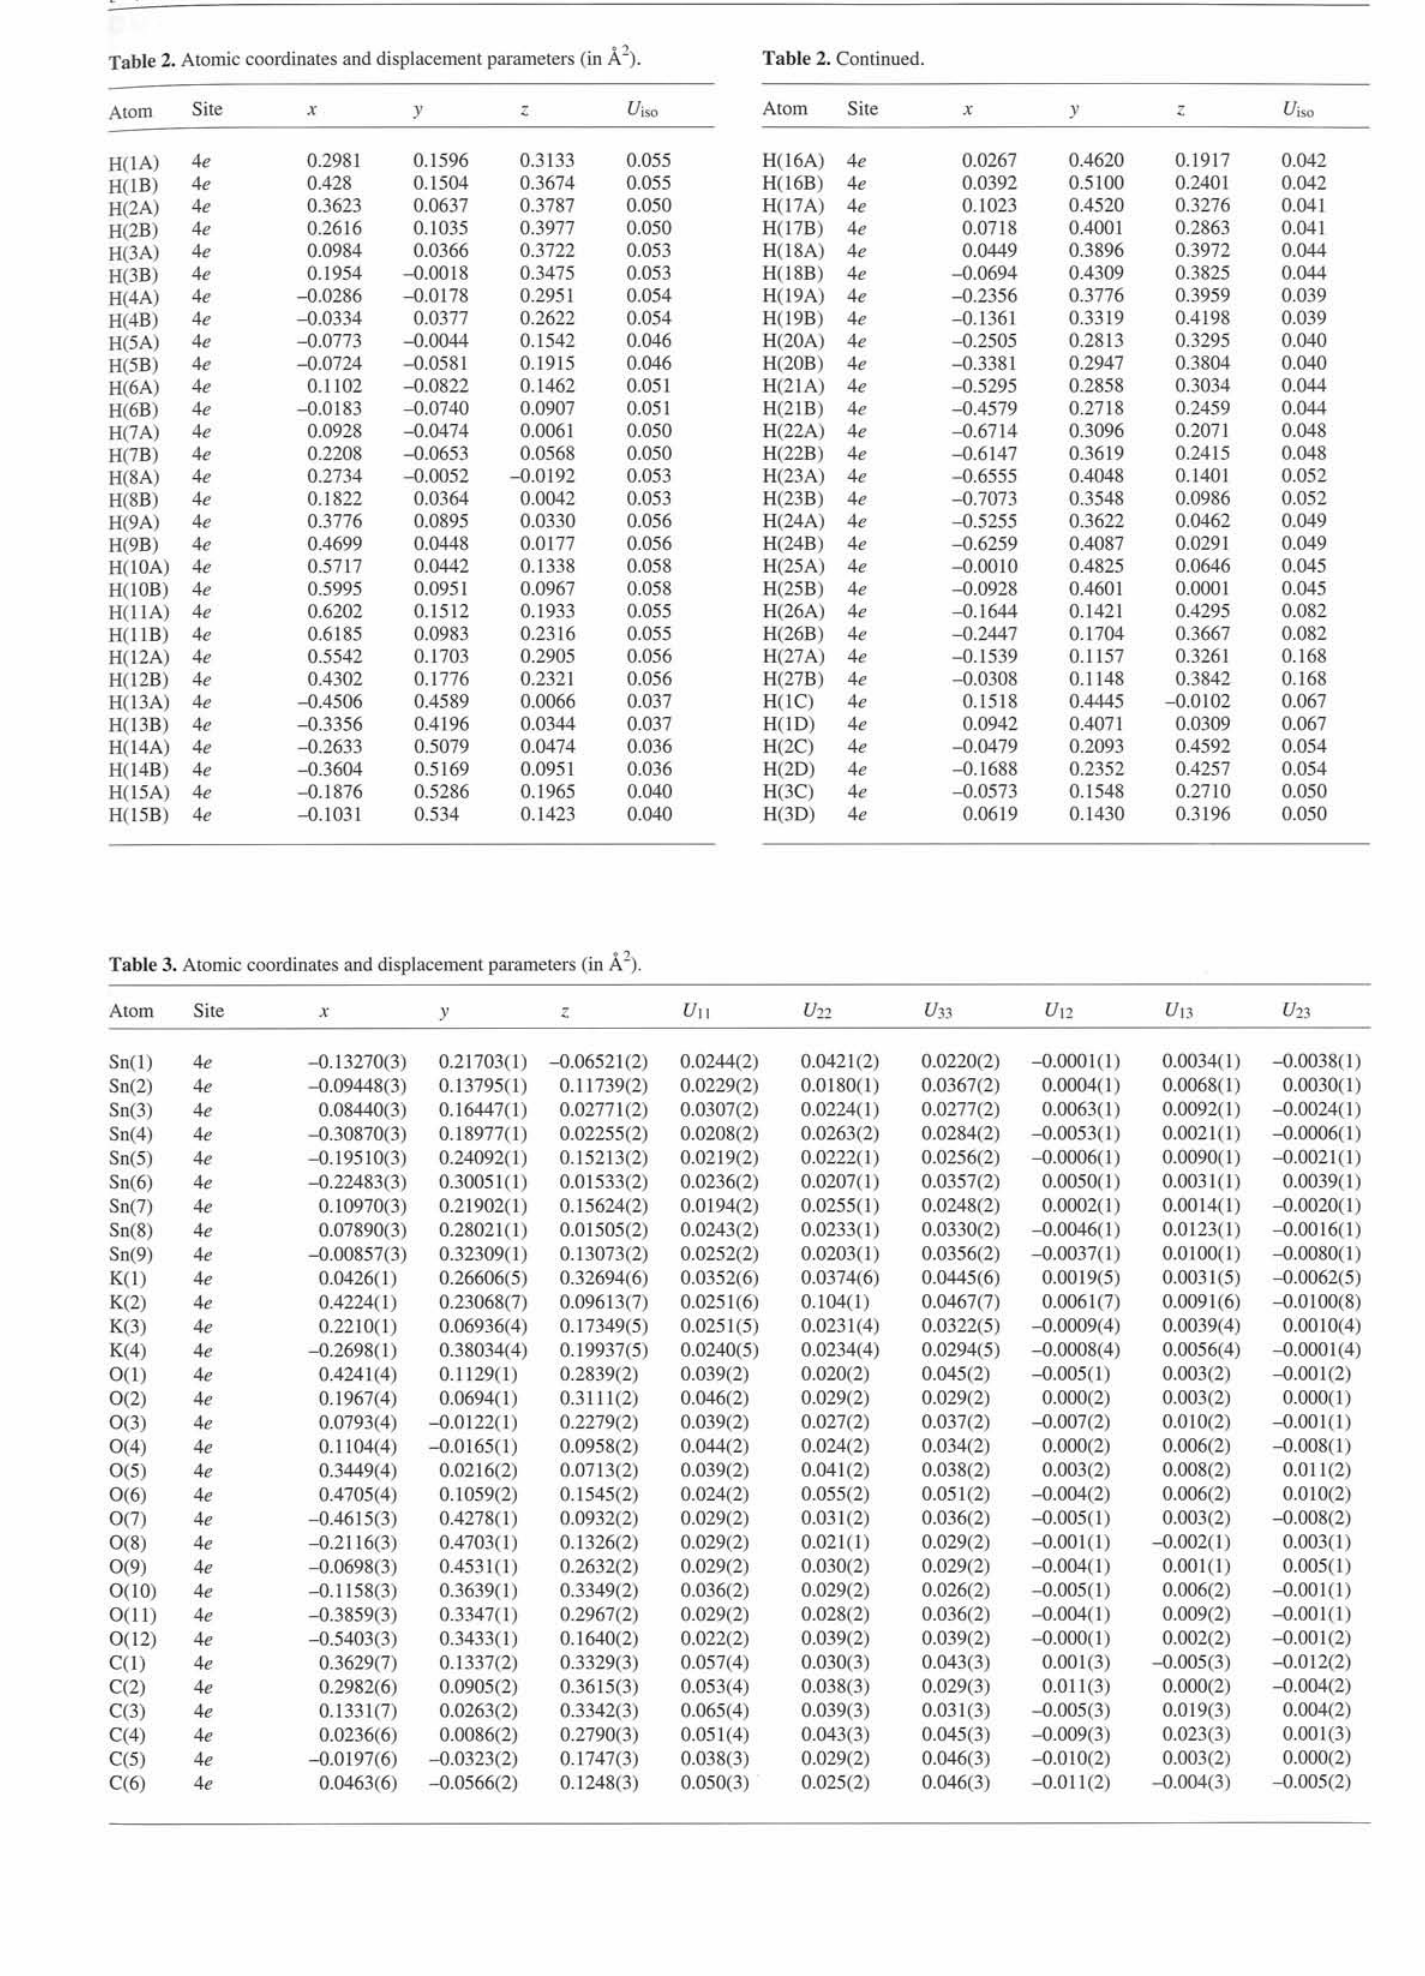
Table 2. Atomic coordinates and displacement parameters (in Á 1 ). Table 2. Continued.